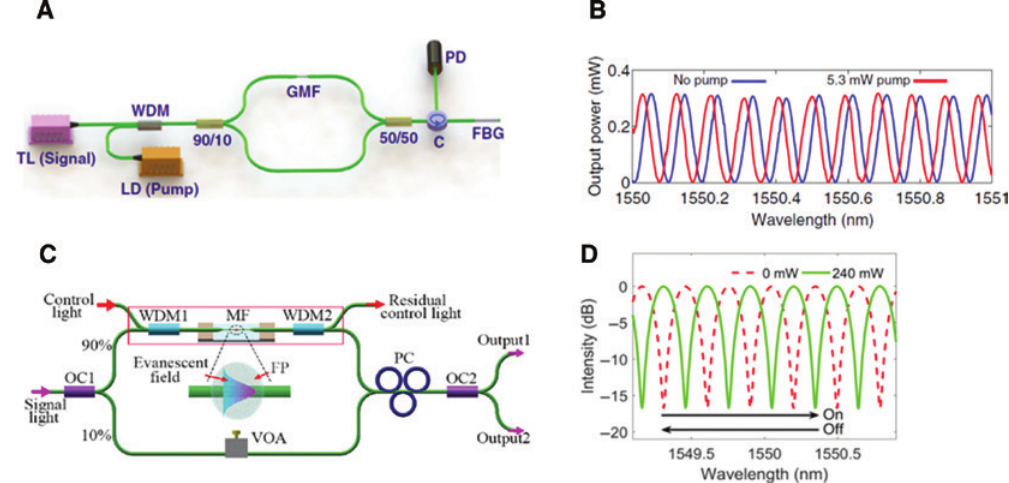
Figure 5: 2D materials-based thermo-optic modulation with fiber. (A) Schematic experimental setup of an all-optical modulator by cladding graphene layer onto one arm of a Mach-Zehnder interferometer; the phase shift was induced by thermo-optic effect. (B) Measured interference fringes of the modulator shown in part (A) with (red) and without (blue) pump [137]. (C) Schematic experimental setup of a phosphorene-based all-optical modulator; FP represents fluorinated phosphorene. (D) Measured interference spectra of the modulator shown in part (C) with (green solid line) and without (red dashed line) pump [136]. (A and B) Reproduced with permission [137]. Copyright 2015, American Chemical Society. (C and D) Reproduced with